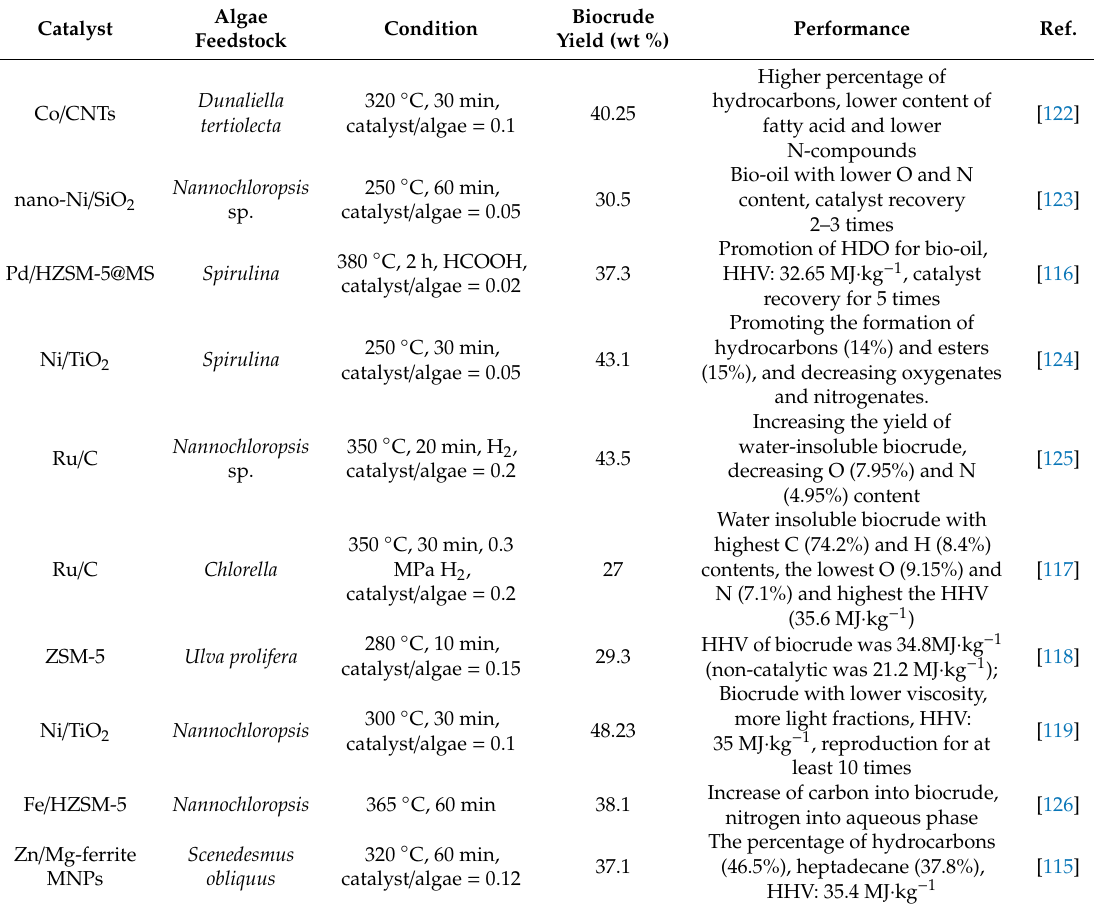
Table 5. Catalytic HTL of algae with heterogeneous